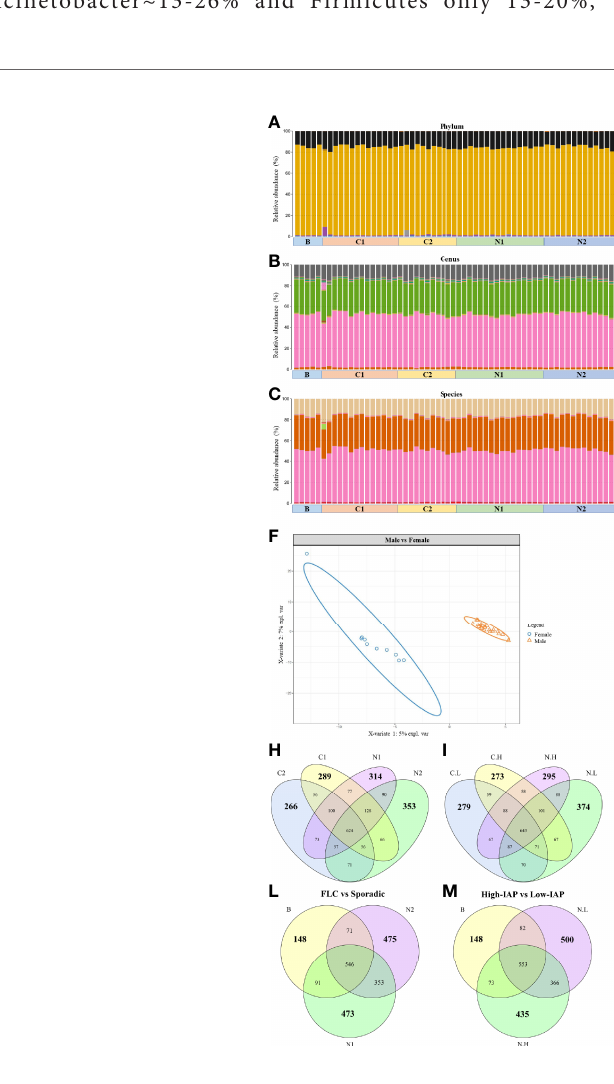
FIGURE 1 | Overall landscape of lung cancer microbiome: the same dominant species and a variety of subgroup-speci fi c microbes in low abundance. Since they were derived from the same organ, all the samples had the same dominant phylum (A) , genus (B) , and specie (C) . Notably, subjects ’ microbiome could be separated by PLSDA analysis based on characters: FLC (D) , IAP (E) , gender (F) , and smoking (G) . OTU details in four subgroups, subgroup-speci fi c OTU were marked in bigger numbers: (H) FLC vs Sporadic lung cancer; (I) High-IAP vs Low-IAP; (J) Female vs Male; (K) smoker vs never smoker. The comparison among subgroup ’ s normal tissue and the benign control: (L) FLC normal vs sporadic normal vs benign; (M) High-IAP normal vs Low-IAP normal vs benign; (N) Female normal vs Male normal vs benign; (O) Ever smokers ’ normal vs never smokers ’ normal vs benign. C1/N1, cancer/normal tissue of familial lung cancer; C2/N2, cancer/normal tissue of sporadic lung cancer; C.H/N.H, cancer/normal tissue from high indoor air pollution region (High-IAP); C.L/N.L, cancer/normal tissue from low indoor air pollution region (Low-IAP); C.F/N.F, cancer/normal tissue of female lung cancer; C.M/N.M, cancer/normal tissue of male lung cancer; C.E./N.E, cancer/ normal tissue from ever smokers; C.N/N.N, cancer/normal tissue from never smokers; B, benign